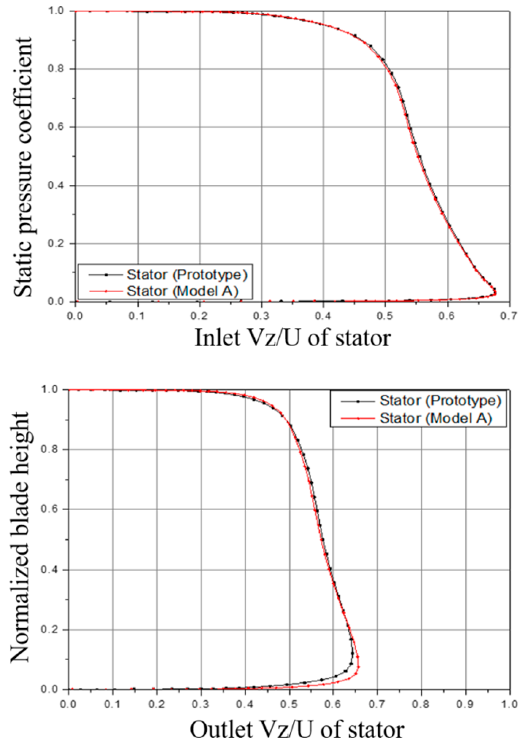
Figure 8. Averaged circumferential values of aerodynamic parameters of the stator.